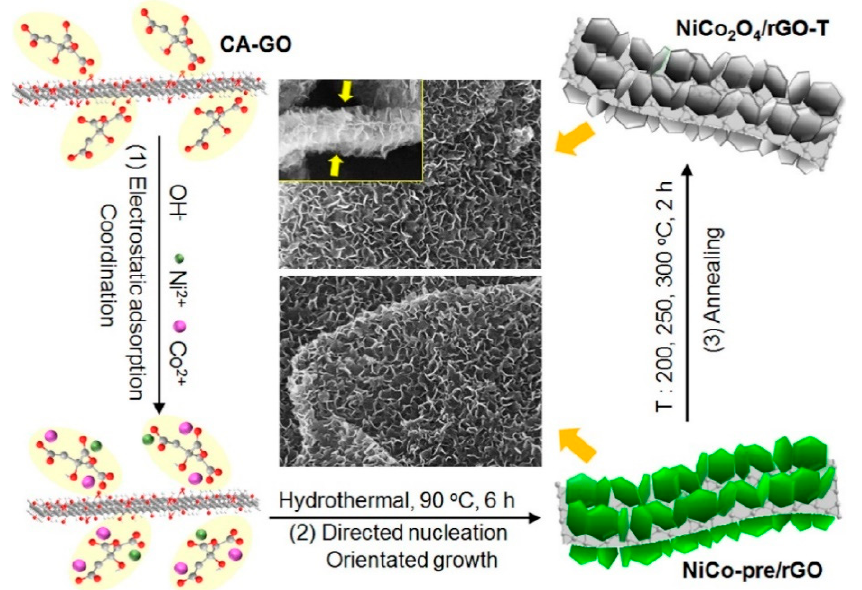
Figure 1. Schematic synthesis strategy of the honeycombed-like hierarchical nanosheet array com- posites NiCo 2 O 4 /rGO. Reproduced with permission from [36]. Copyright 2020, Elsevier.